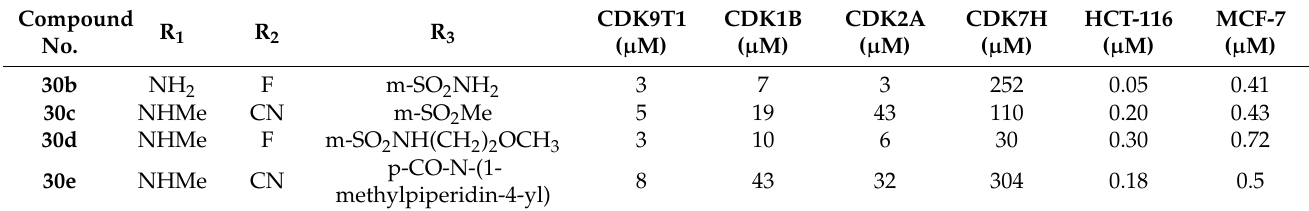
Figure 33. Structure of tri-substituted pyrimidine hybrids and the most promising compound 30a . Table 23. In vitro cytotoxic activities of tri ‐ substituted pyrimidine hybrid compounds 30 ( b – e ).